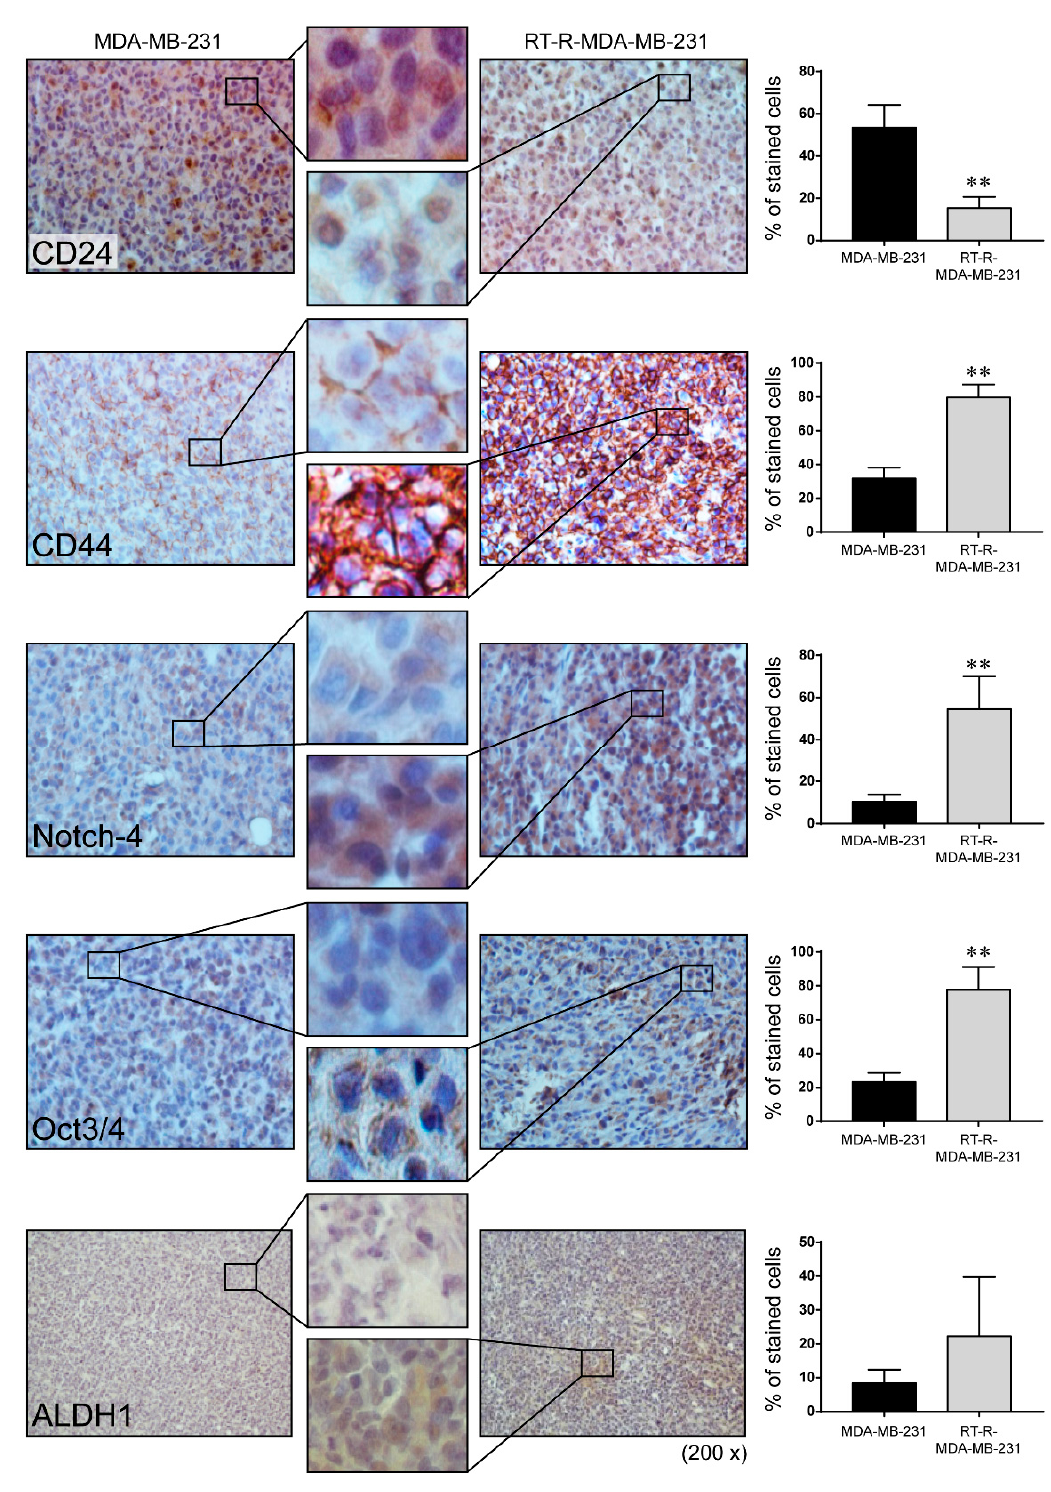
Figure 4. Cancer stem cell markers CD44, Notch-4, and Oct3/4 but not ALDH1 were highly detected in the tumor tissues from RT-R-MDA-MB-231 cell-injected mice. Cancer stem cell markers including CD24, CD44, Notch-4, Oct3/4, and ALDH1 were detected in the tumor sections using the specific antibodies as described in the Methods. The sections were counterstained with hematoxylin and examined under a light microscope. The representative images were presented (magnification; ×200 and ×400). Data represent mean values ± SEM ( n = 10). ** p < 0.01 compared with the MDA-MB-231-injected mice.